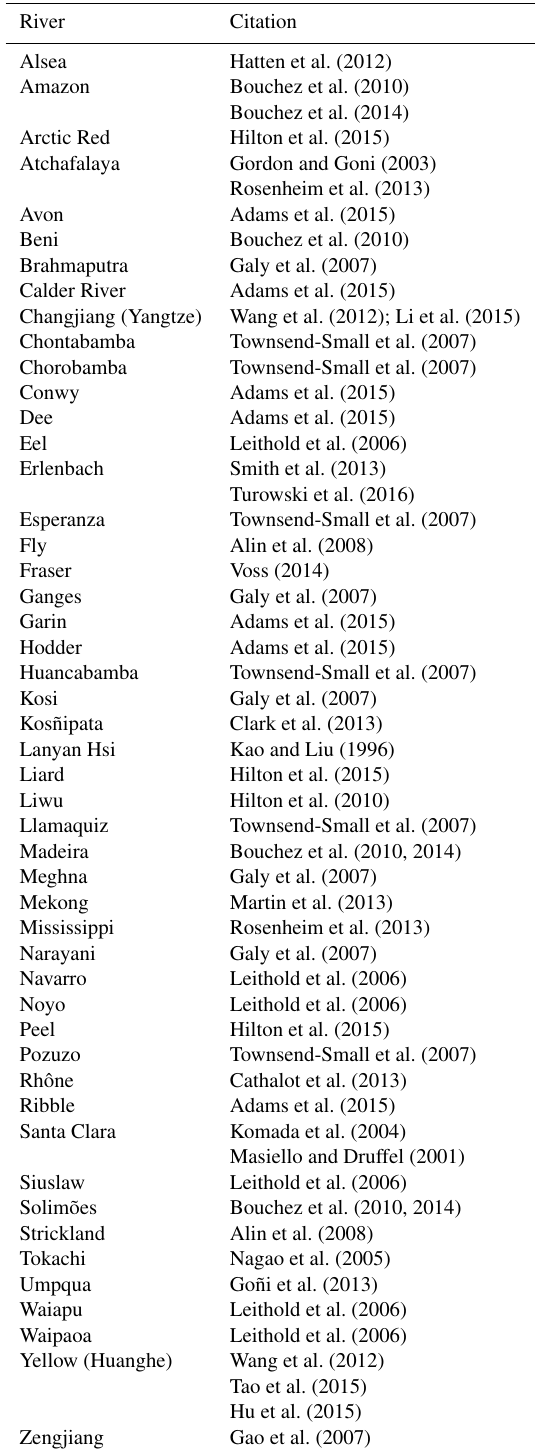
Table 1. List of all rivers and their associated citations included in the radiocarbon